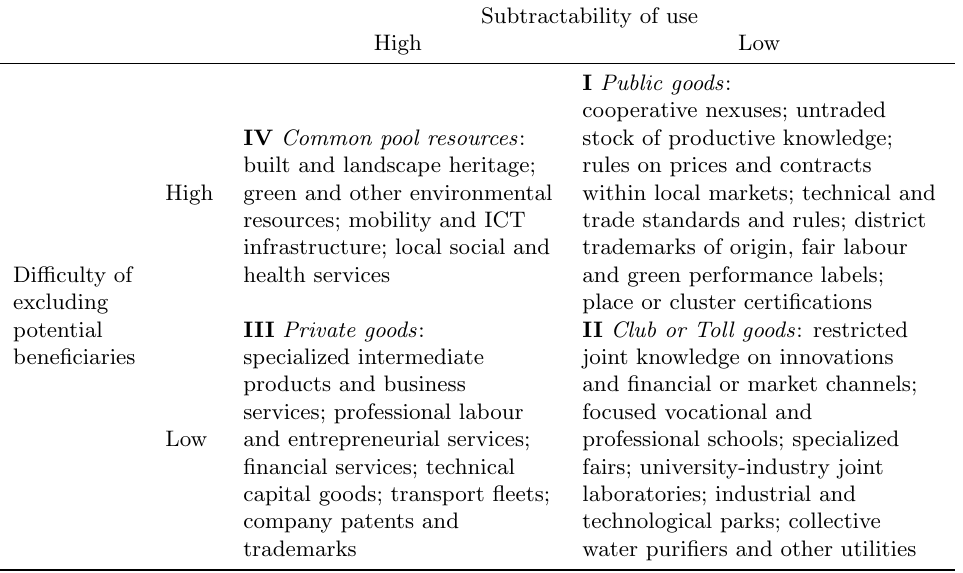
Table 1: Examples of types of products and services in